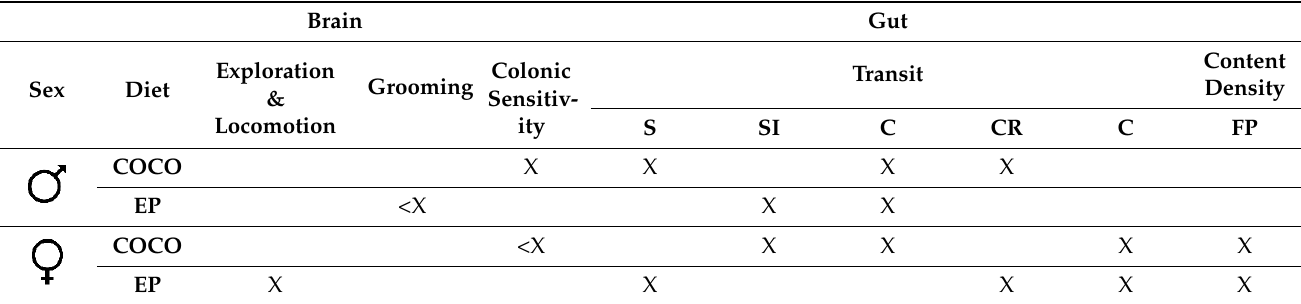
X EP X X X X Compared with AIN-93G (termed as control or SOY throughout the text) diet containing 7% soybean oil, male and female rats exposed to modified AIN-93G diet containing 3.5% of soybean oil supplemented with 3.5% of coconut oil (COCO) or with 3.5% of evening primrose oil (EP) displayed some alterations in brain (emotional behavior, exploration and locomo- tion, grooming) and gut functions (transit, colonic sensitivity, content density) that were significant (X) or almost signifi- cant (<X). Abbreviations: C, cecum; CR, colorectum; FP, fecal pellets (within the colorectum); S, stomach; SI, small intestine.